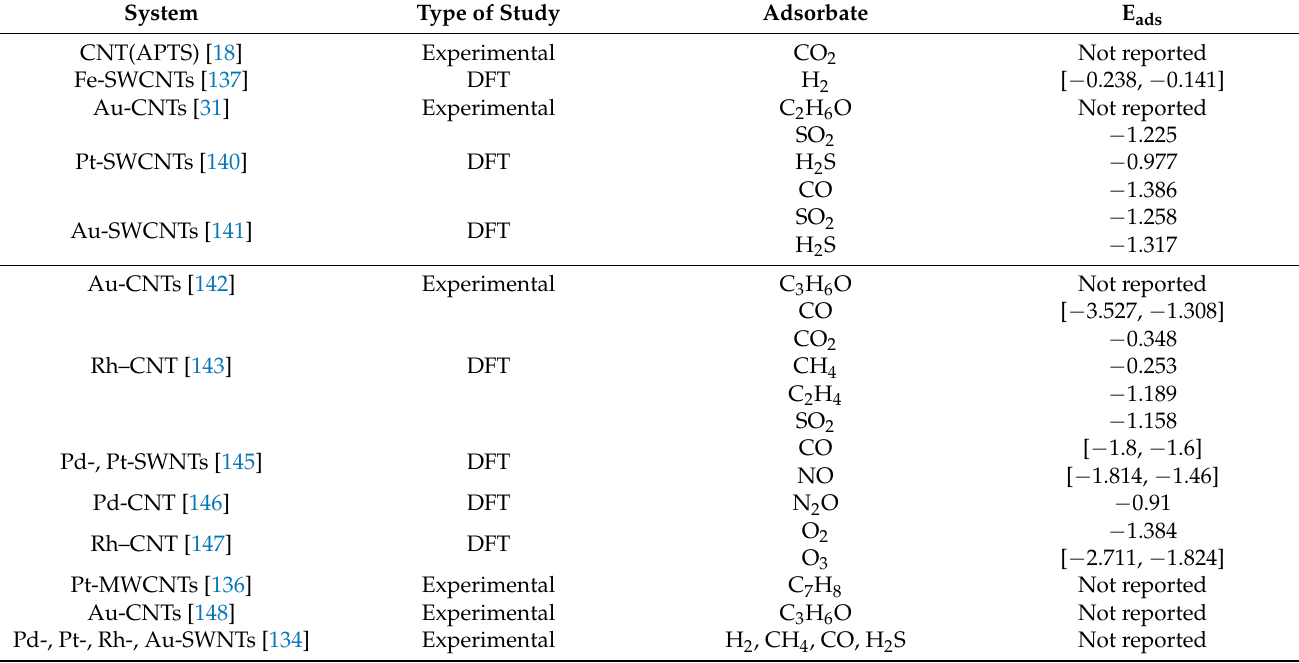
Table 7. Summary of adsorption energies E ads (in eV) for different TM-doped nanotubes systems and adsorbates. The type of study is also